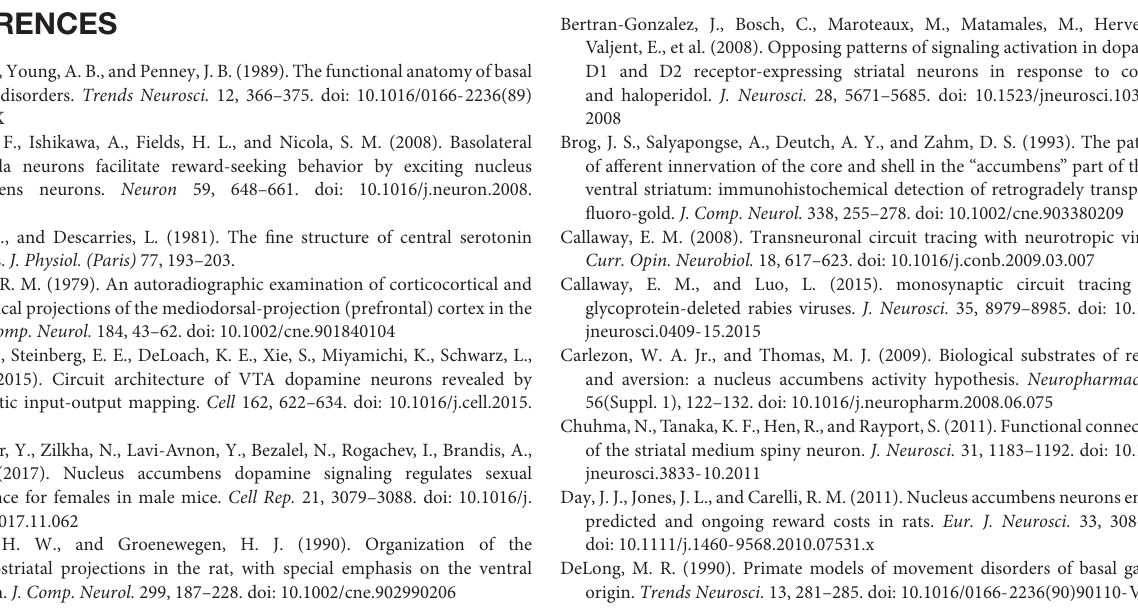
FIGURE S1 | Confocal images showing almost all eGFP- and dsRed-double-positive neurons (starter cells) were also DARPP-32-positive in